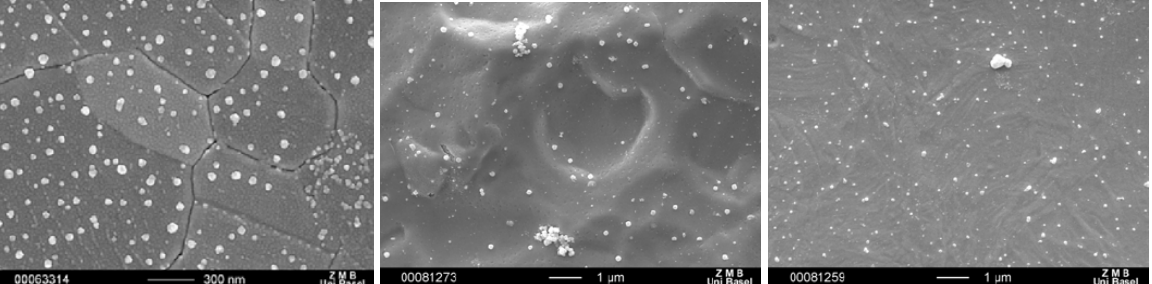
Figure 17. SEM image of nanostructures of compound 1 on Au(111) (left), on rough Ti (middle) and on rough steel